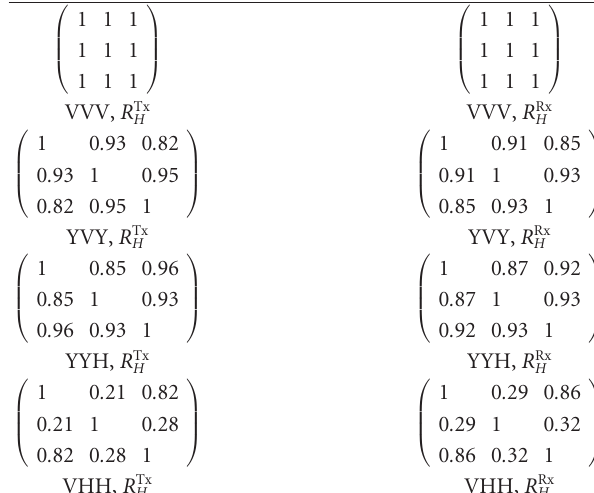
Table 3: Correlation matrix for di ff erent polarization schemes in NLOS environment. ⎛